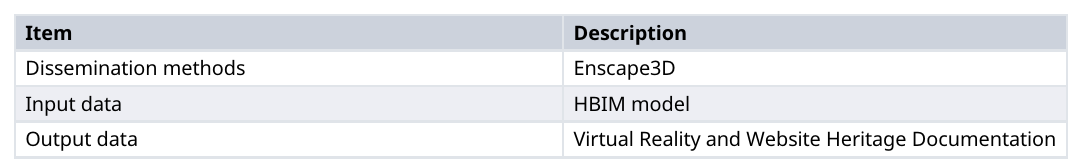
Table 5. Dissemination phase for the Société Immobilière